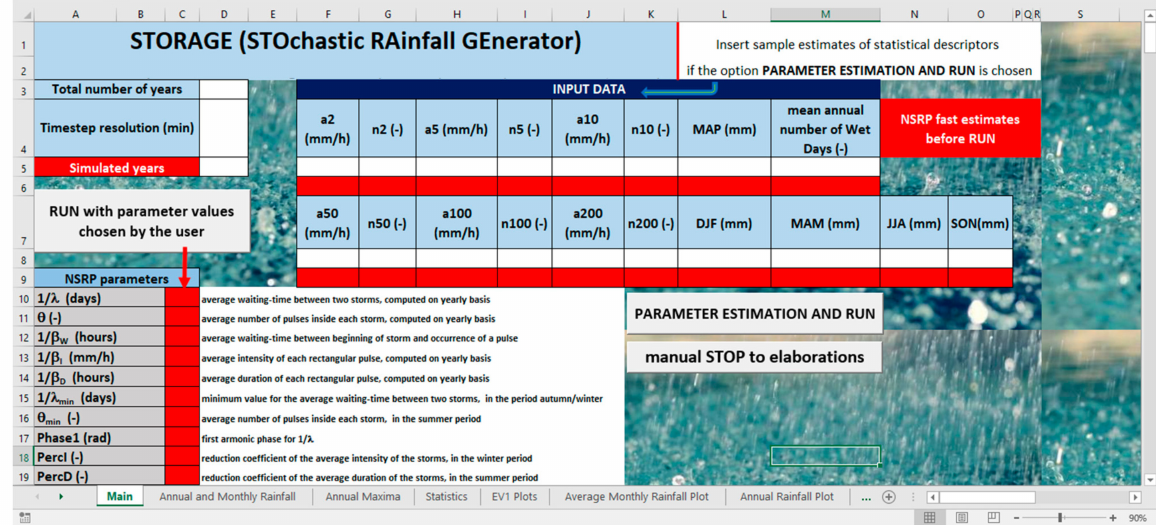
Figure 3. Interface of the Main worksheet of STORAGE after enabling the VBA macros’